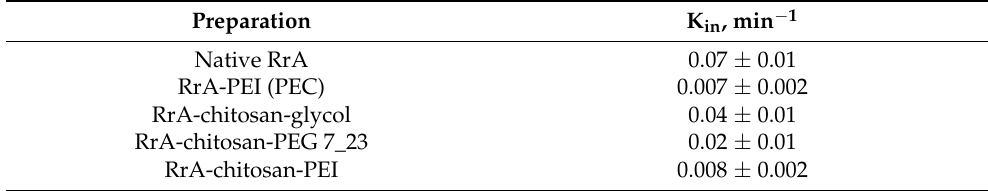
Table 7. Values of the trypsinolysis rate (inhibition constant, K in ) for the RrA conjugates. Preparation